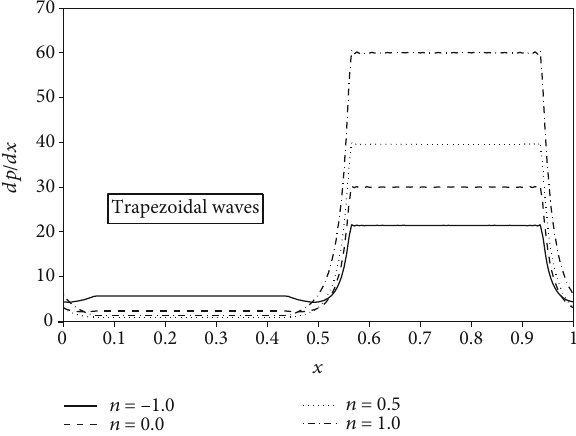
Figure 12: Variation of pressure gradient with x for di ff erent values of n for fi xed values of φ = 0 : 5 , β = 4 , We = 0 : 6 , and Q = − 2 .